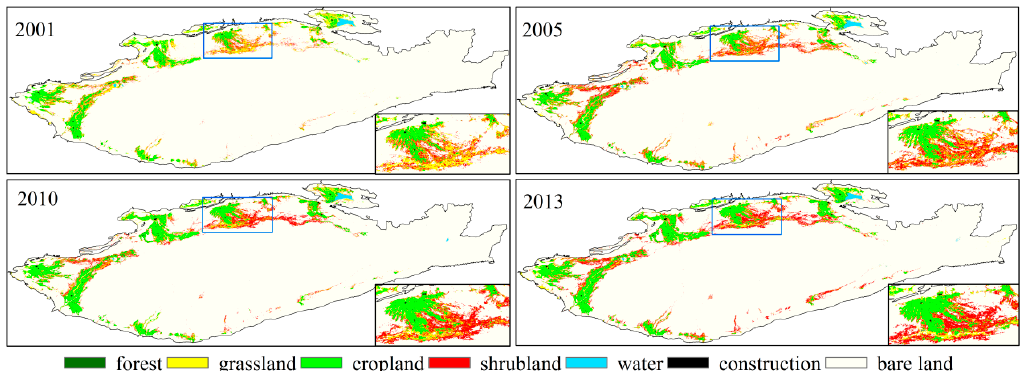
Figure 2. Spatial patterns of different land cover types in 2001, 2005, 2010, and 2013.